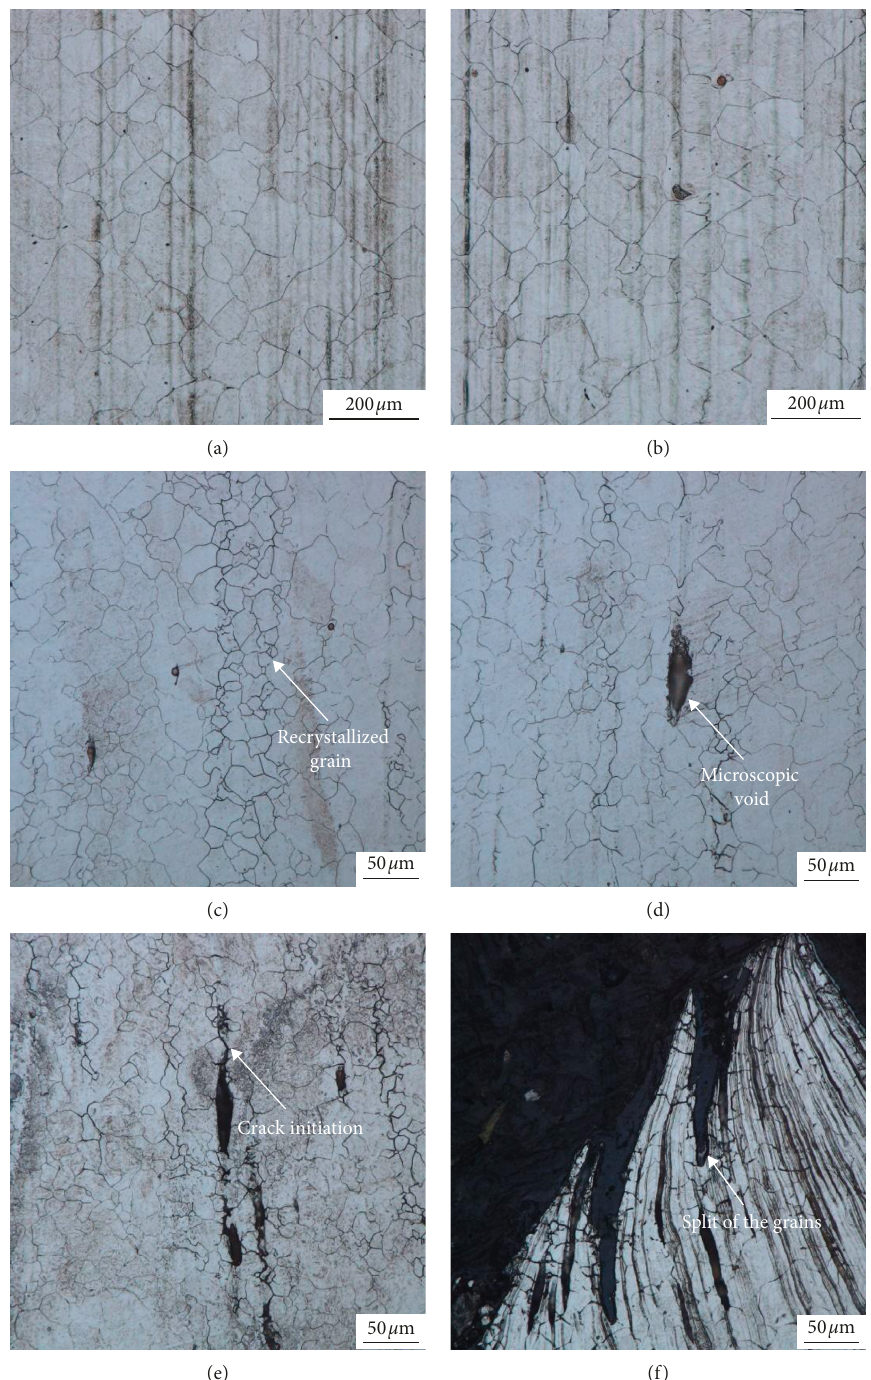
F IGURE 5: Microstructure transformation during the hot tensile process: (a) ε ε 0 . (cid:31)